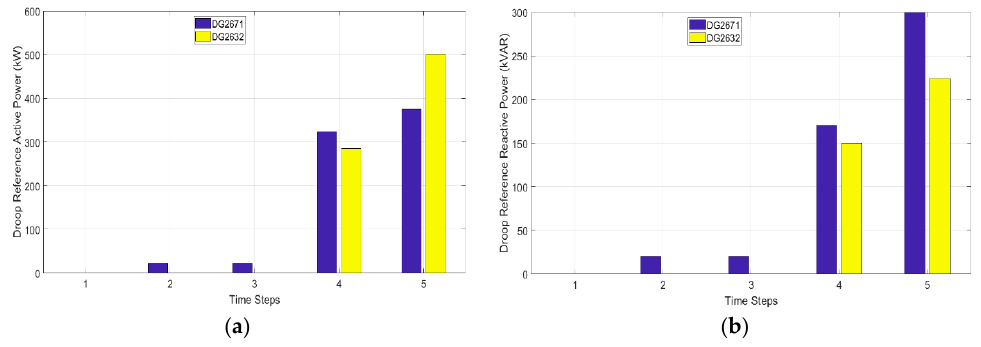
Figure 12. ( a ) Droop three-phase active power reference ( b ) Droop three-phase reactive power reference.